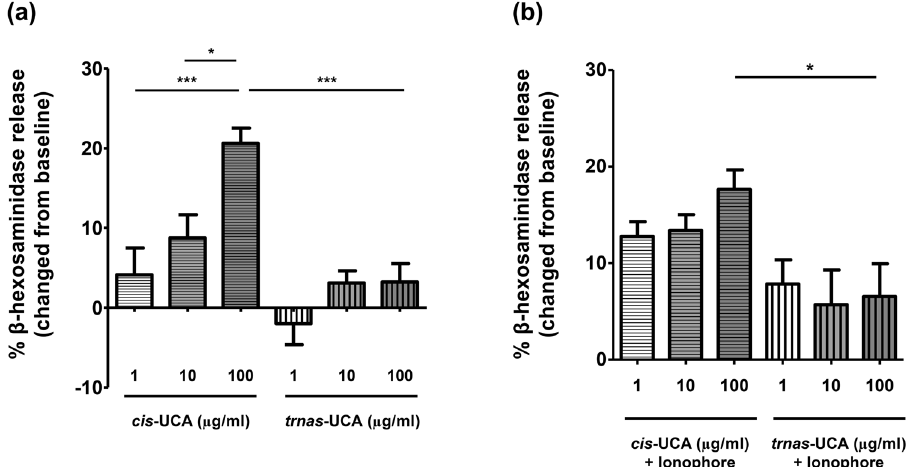
Figure 5. Effect of cis - and trans -UCA on IgE-mediated ( a ) and calcium-mediated ( b ) degranulation of LAD-2 cells. Mast cell degranulation levels were investigated using the beta-hexosaminidase release test. The control comprised LAD-2 cells sensitised with IgE and stimulated with streptavidin peroxidase ( a ) or only stimulated with calcium ionophore ( b ) without UCA pre-treatment, which yielded 57.5 ± 6.9% and 68.9 ± 9.6% of beta- hexosaminidase release; respectively. * , *** P < 0.05, 0.001, obtained by one-way ANOVA with Bonferroni’s post-hoc